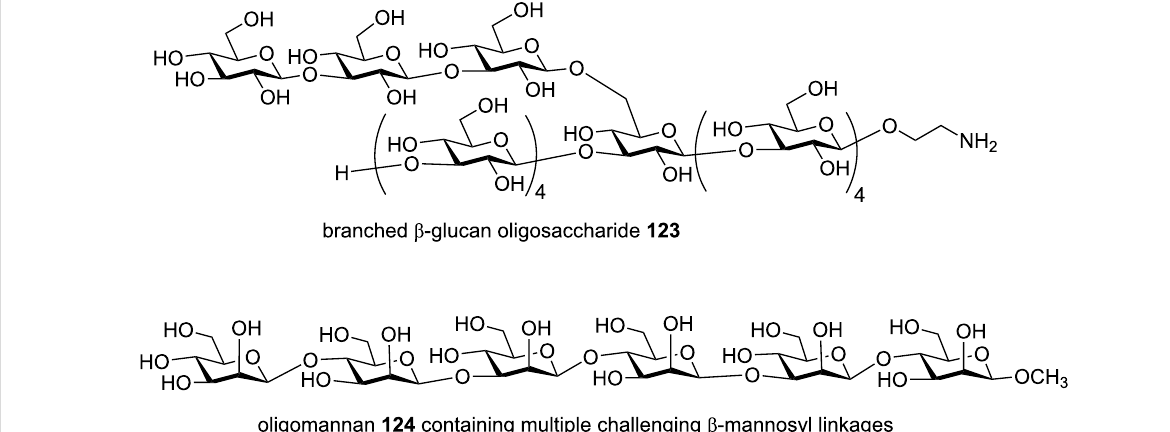
Figure 6: Representative microbial and mammalian oligosaccharides synthesized by the preactivation-based thioglycoside method.